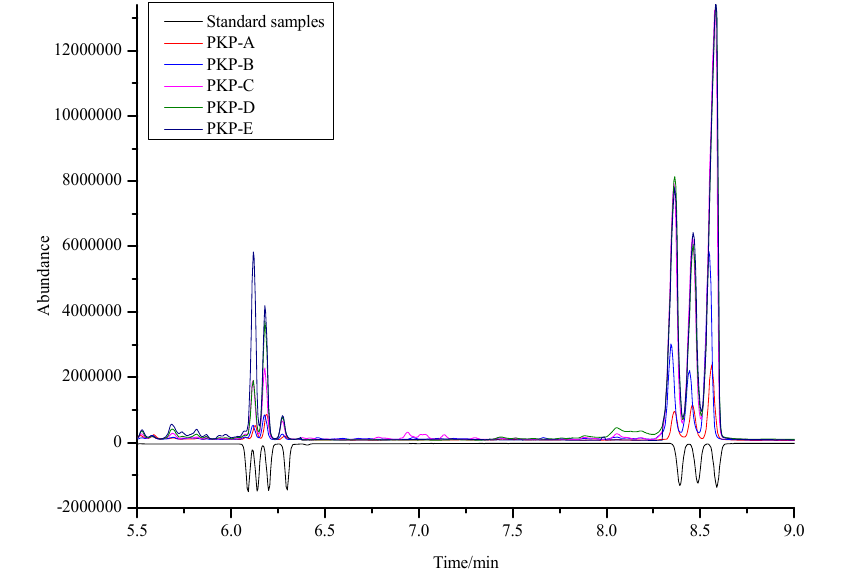
Figure 1. Monosaccharide composition of PKPs and standard samples (500 ng·mL − 1 ).